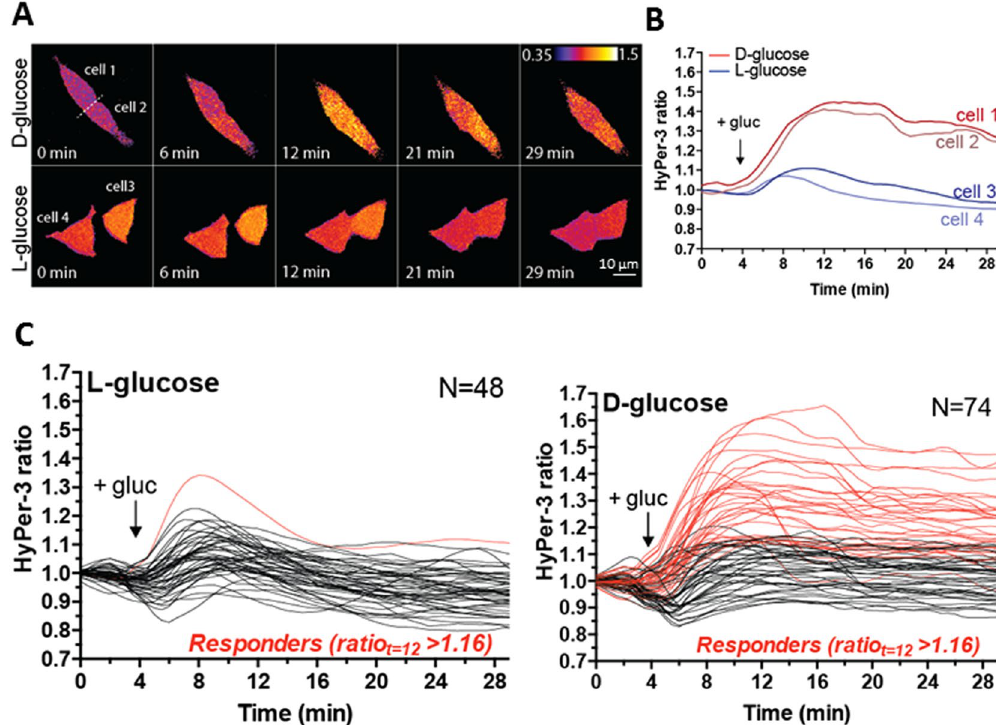
Figure 3. Glucose increases H 2 O 2 levels in INS-1 cells. ( A ) Time-lapse ratio imaging of rat INS-1 cells following treatment with 18 mM D- or L-glucose at t = 4 min. ( B ) Quantification of HyPer-3 ratio of the cells shown in panel A. ( C ) Single-cell quantification of INS-1 cells treated as in panel A, showing heterogeneity in the response to D-glucose from three independent experiments. In 33 out of 74 cells, the HyPer-3 ratio rose almost immediately up to a maximum of ~1.65 in 8–10 minutes after glucose